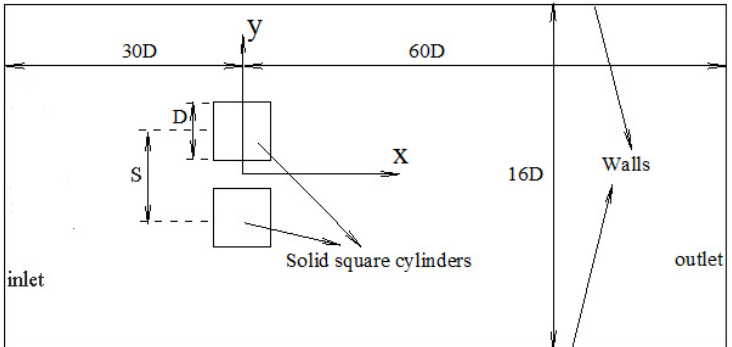
Figure 1. Computational domain and coordinate system.